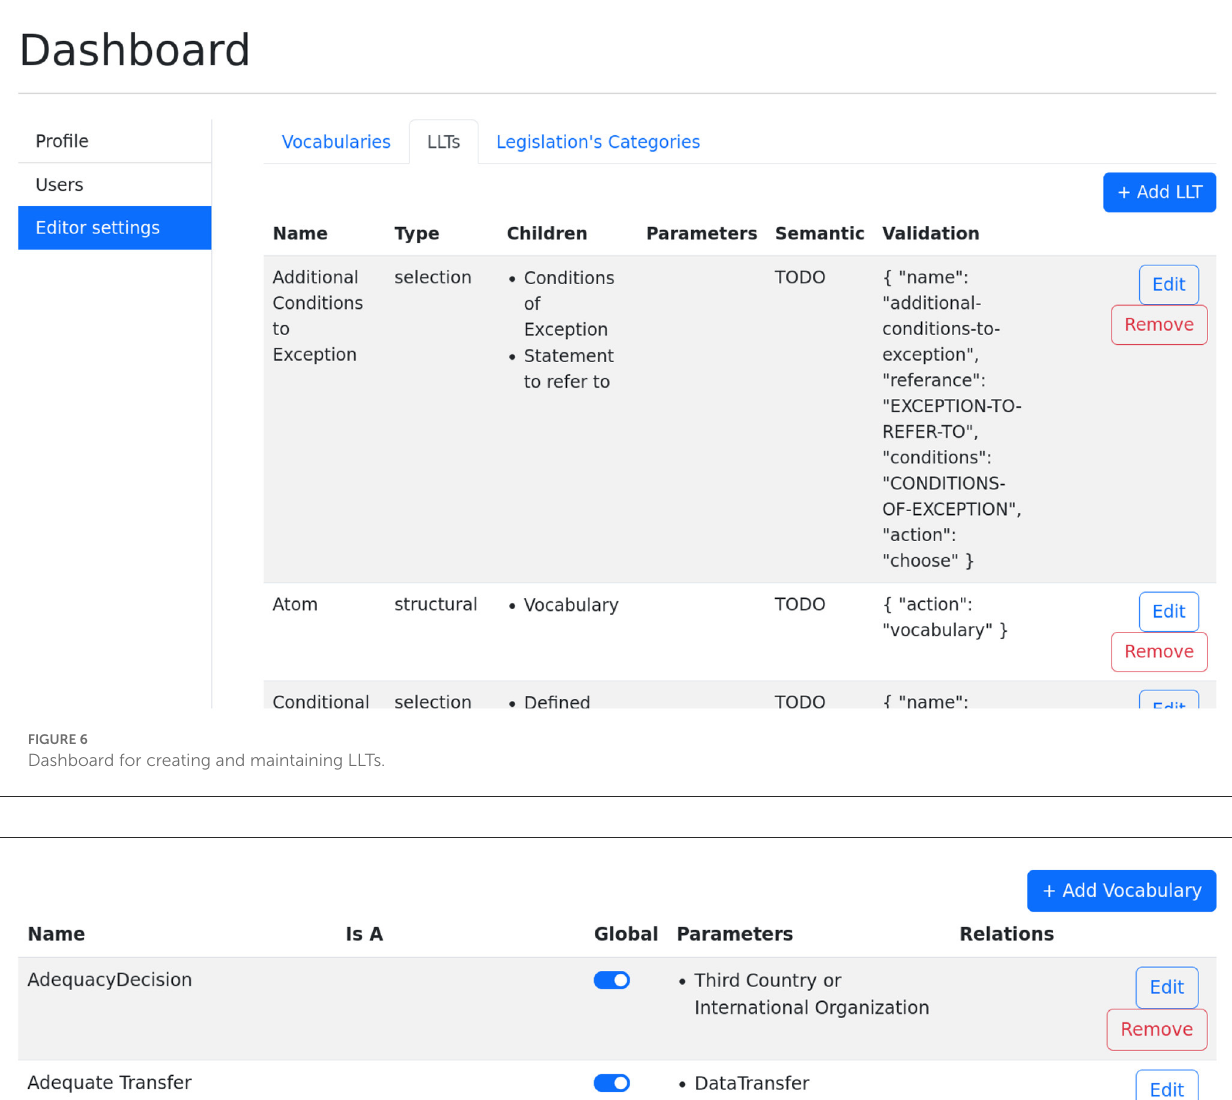
FIGURE7 Dashboard for creating and maintaining